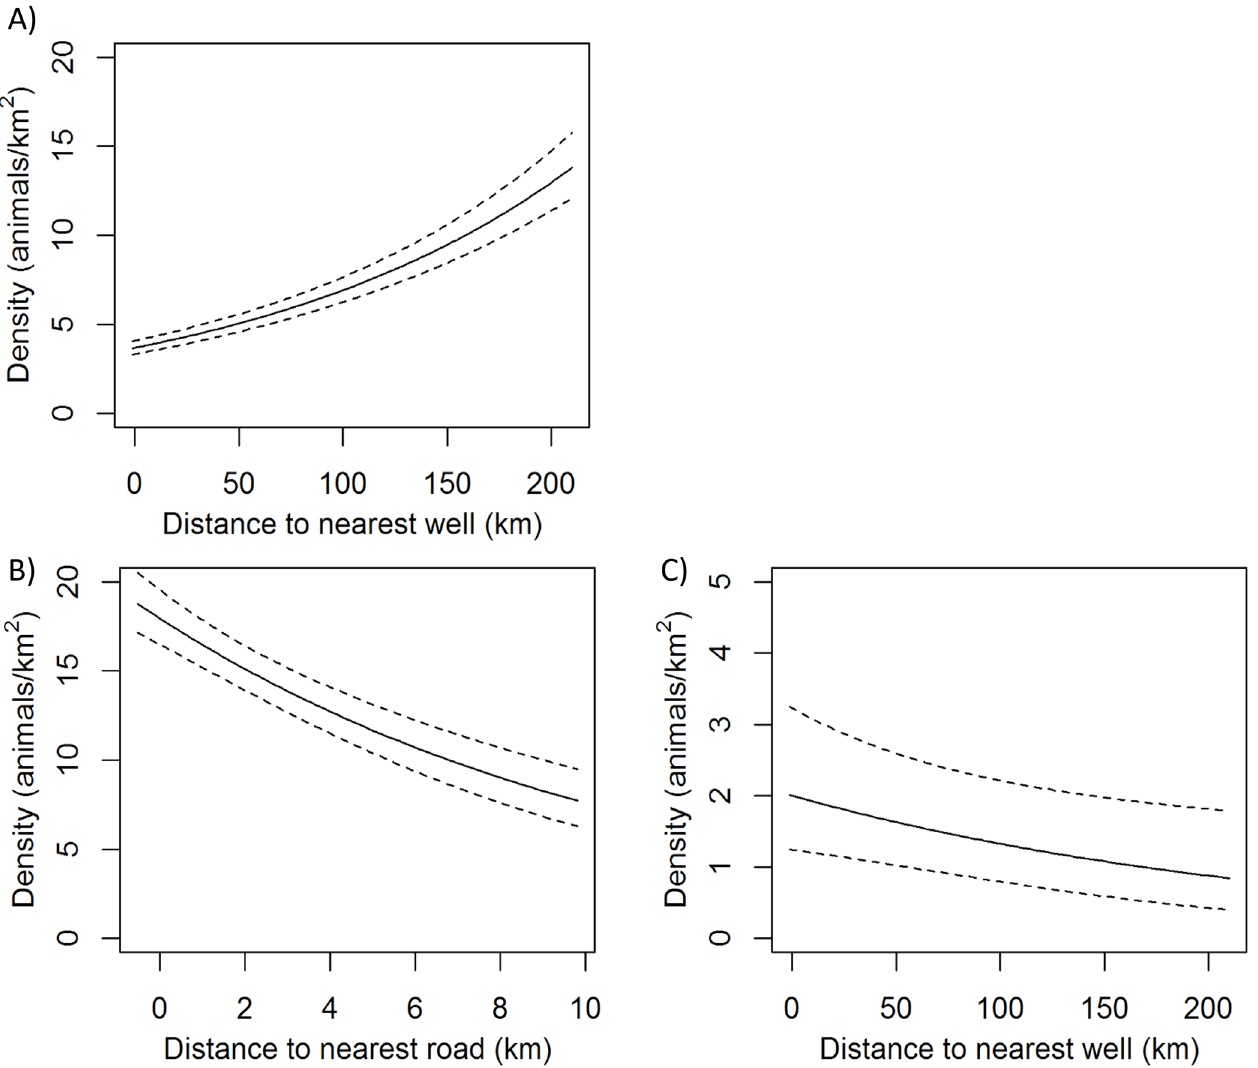
Fig 5. Modeled response of density (individuals/km 2 ) of small mammal species groups to anthropogenic covariates: distance to nearest oil/gas well or distance to nearestroad. Dotted lines show 95% confidenceinterval. Panel A) shows white-tailedprairiedogs, B) Wyoming groundsquirrels, and C) leporids( Sylvilagus sp. and Lepus townsendii ). Least chipmunksdid not respondsignificantly to anthropogenic